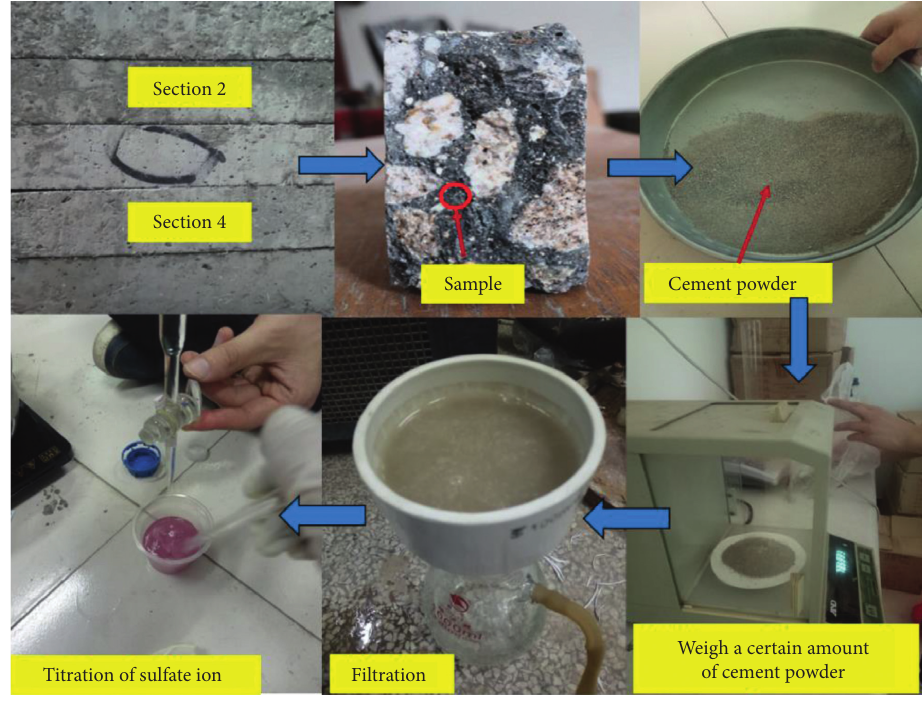
Figure 5: The detailed process of the sulfate concentrations test. Table 4: The number of pores in each